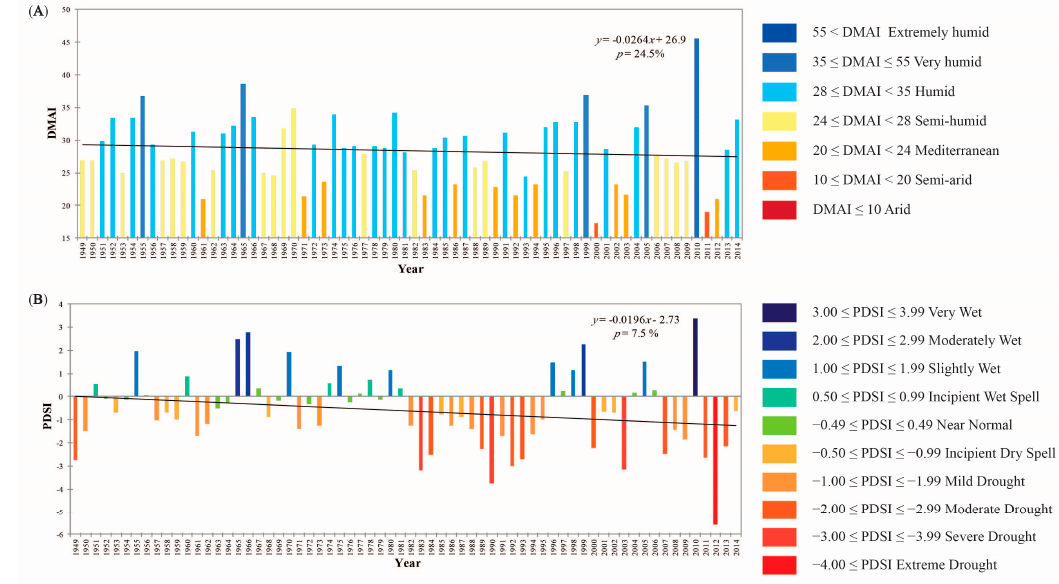
Figure 12. The distribution of the mean annual ( A ) the DMAI and ( B ) the PDSI, and their trends forthe CSPB (Hungary and Vojvodina jointly) during the control period 1949–2014. Trends of the DMAI and the PDSI are presented with solid, black lines and trend equations, and p is